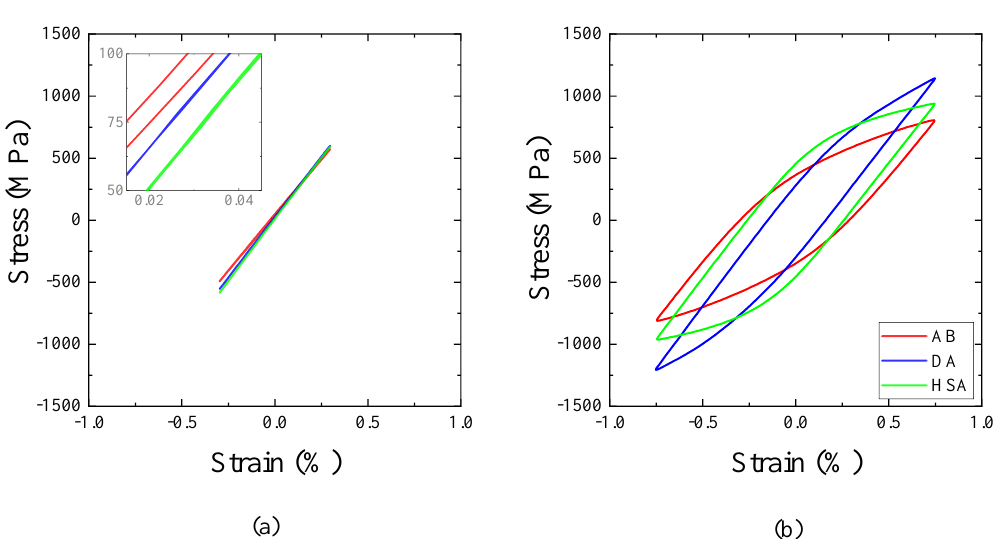
Figure 10. Hysteresis of transverse specimens in different post-treatments at ( a ) (cid:101) a = 0.3% and ( b ) (cid:101) a =